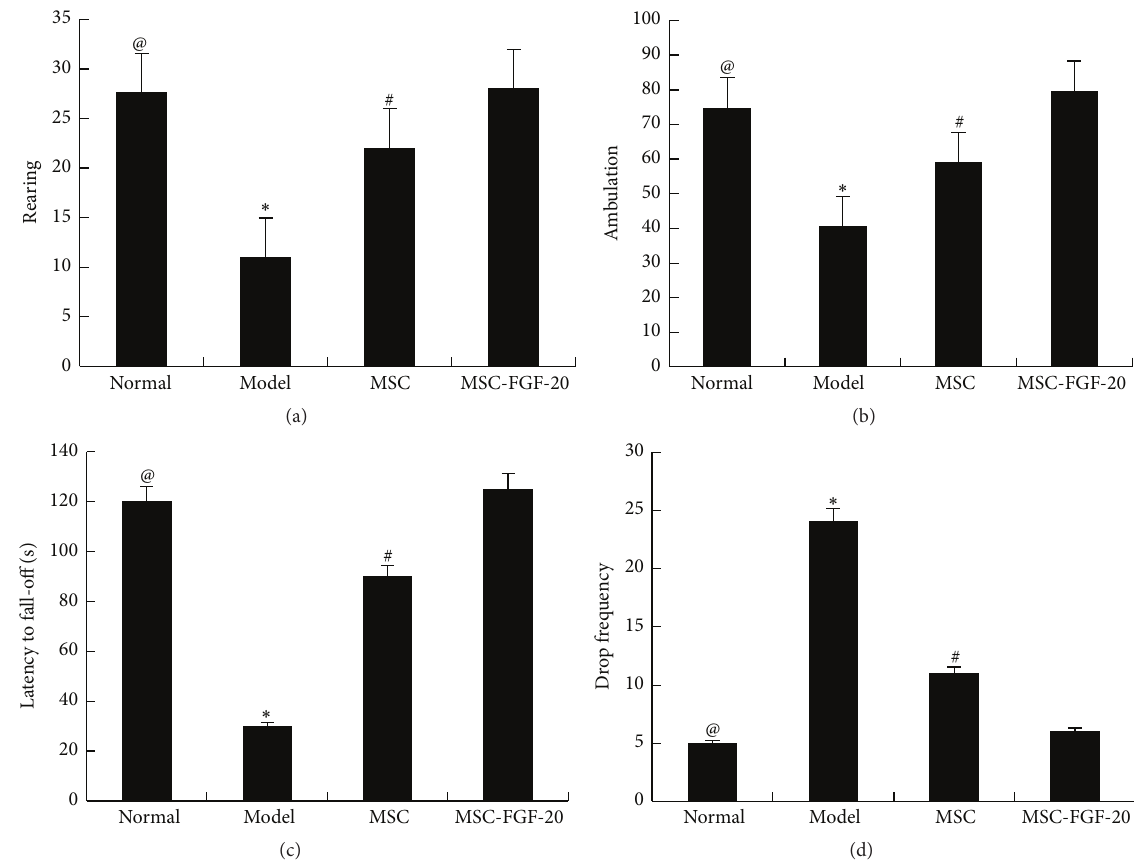
Figure 2: Behavioral changes in mice with PD after cell treatment. (a) Open field versus average number of rearing instances. (b) Open field versus ambulation. (c) Rota rod test versus latency to fall. (d) Rota rod test versus the drop frequency ( @ 𝑝 < 0.01 , the normal group versus the model group; ∗ 𝑝 < 0.01 , the model group versus MSC and MSC-FGF-20 group; # 𝑝 < 0.05 , MSC group versus MSC-FGF-20